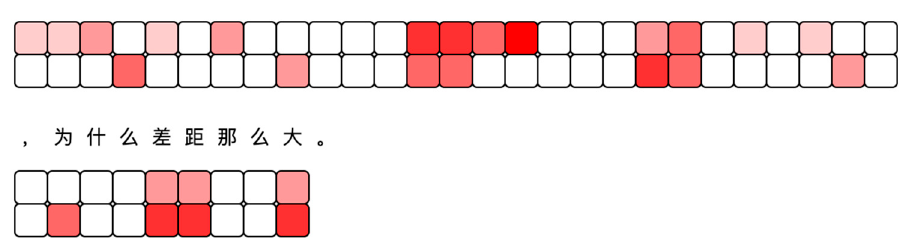
Figure 2. Example for the comments of real online course.